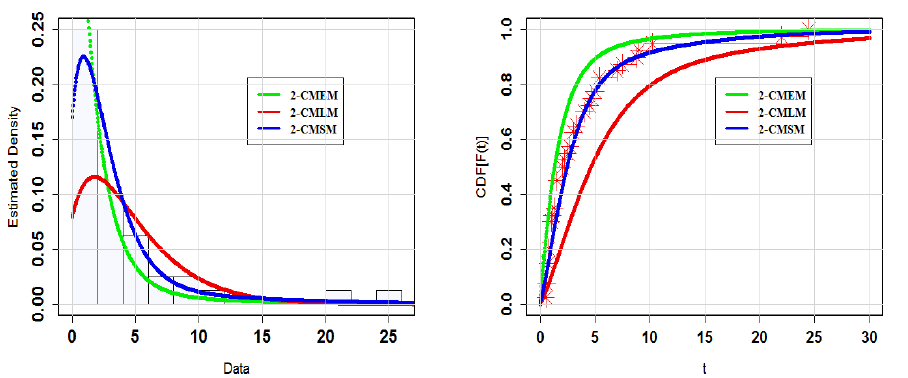
Fig. 15. Plots for the estimated PDFs and CDFs for Dataset I.